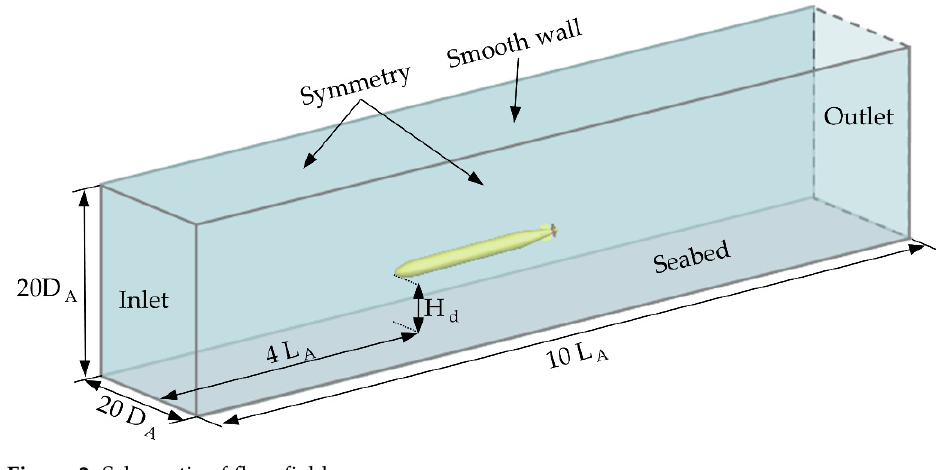
Figure 2. Schematic of flow field.